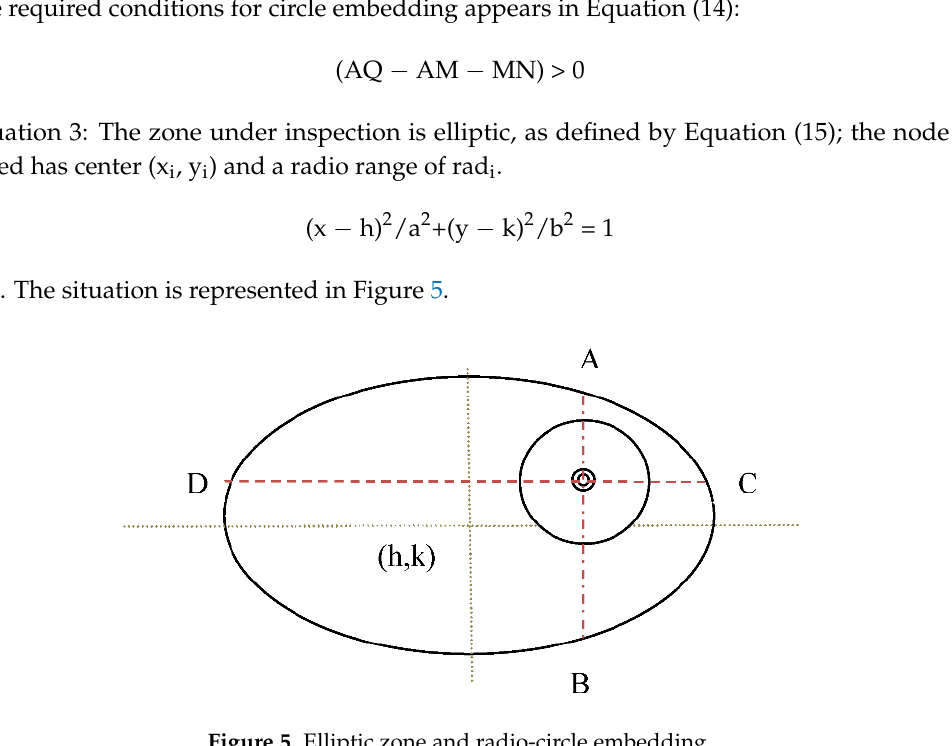
Figure 5. Elliptic zone and radio-circle embedding.